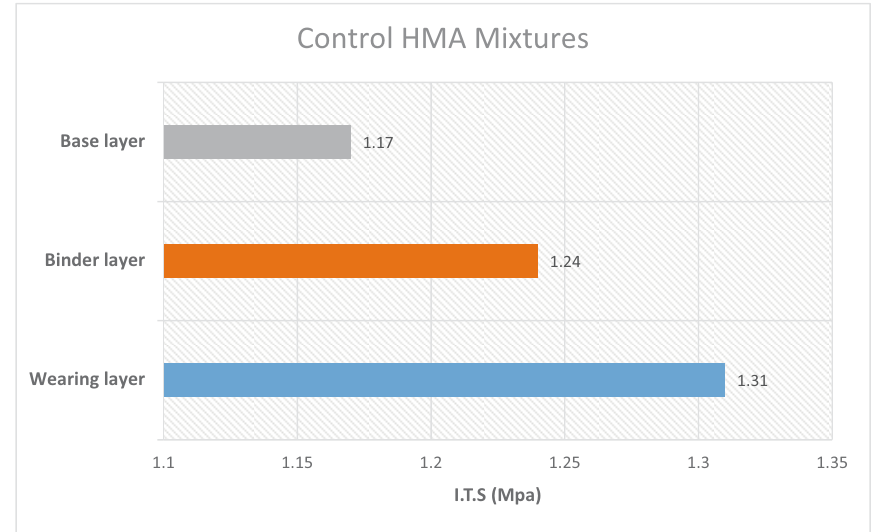
Figure 11: The results of the I.T.S. test for the selected layers.